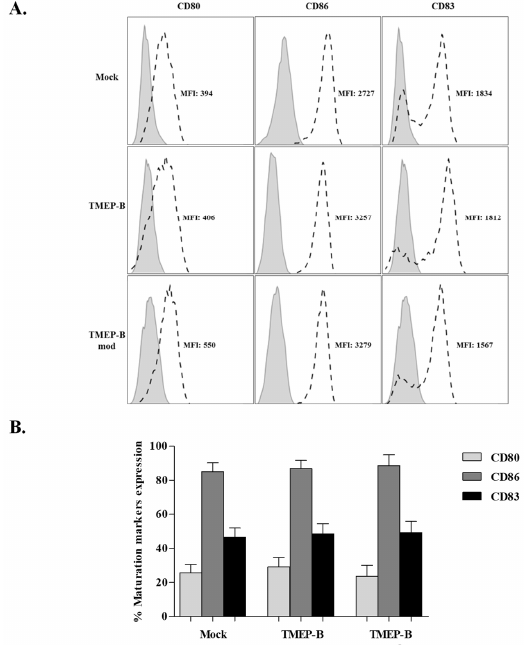
Figure 1. Analysis of maturation markers on DCs from HIV infected patients electroporated with mRNA TMEP-B or TMEP-Bmod. Analysis of maturation markers levels (CD80, CD86, and CD83. ( A ) Histogram showing the mean fluorescent intensity (MFI) in a representative example of all experiments ( n = 17). ( B ) Percentages of CD80, CD86 and CD83 expression on DCs from HIV infected patients electroporated with TMEP-B and TMEP-Bmod ( n = 17). Mock transfected DCs were used as negative controls and pairwise comparisons were made (Mock vs. TMEP-B; Mock vs. TMEP-Bmod; TMEP-B vs. TMEP-Bmod). A cytokine maturation cocktail was added to all co-cultures. Percentages ± SD are shown. Analysis by the Wilcoxon signed rank test (* p < 0.05; ** p < 0.01; *** p < 0.001).